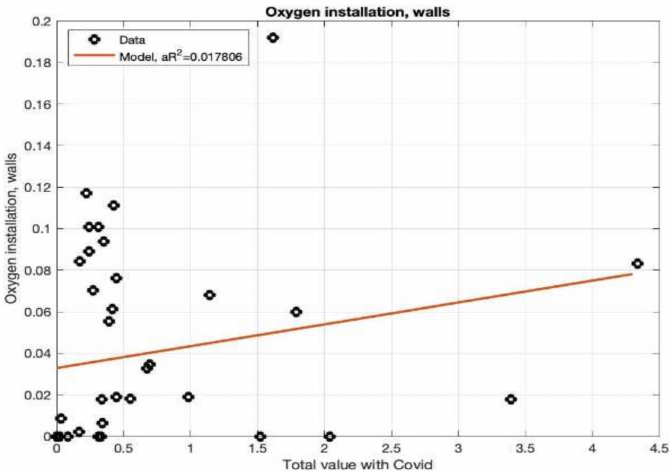
Figure 13. Correlation relationship of total COVID funding vs. installations (oxygen,